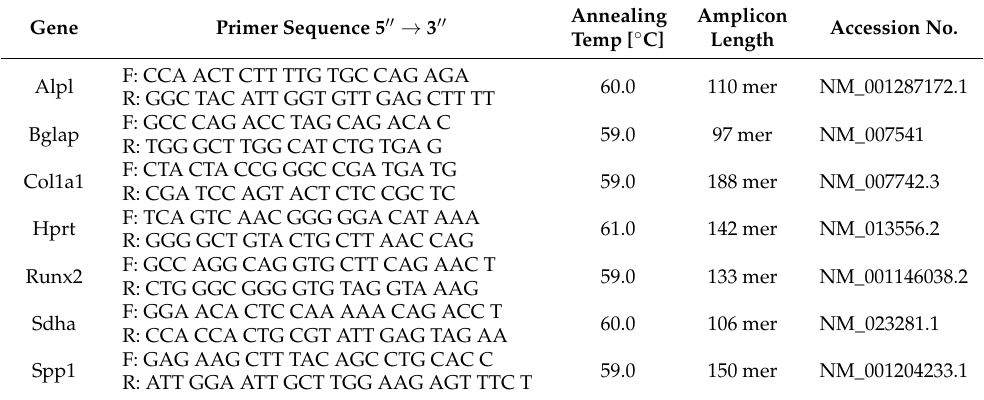
Table 1. RT-qPCR primer information. Table shows official NCBI gene symbols, accession numbers, nucleotide primer sequence, annealing temperature, and verified amplicon length (in